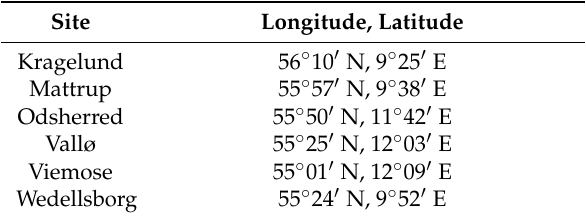
Table A1. Longitude and latitude for each